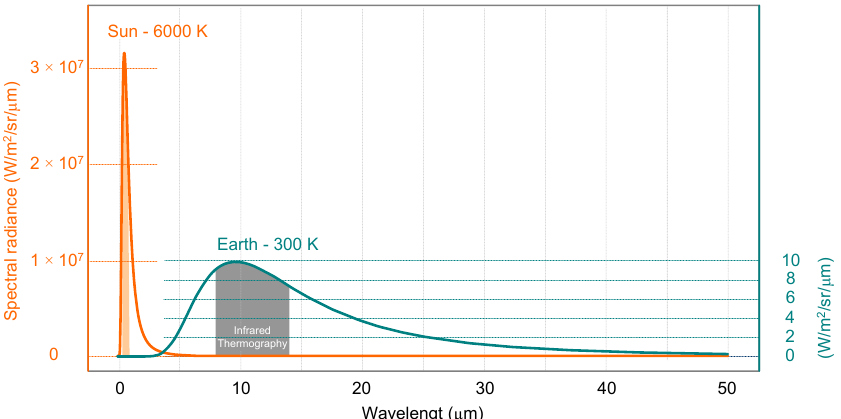
Figure 13. Radiation of the sun and earth by wavelengths.